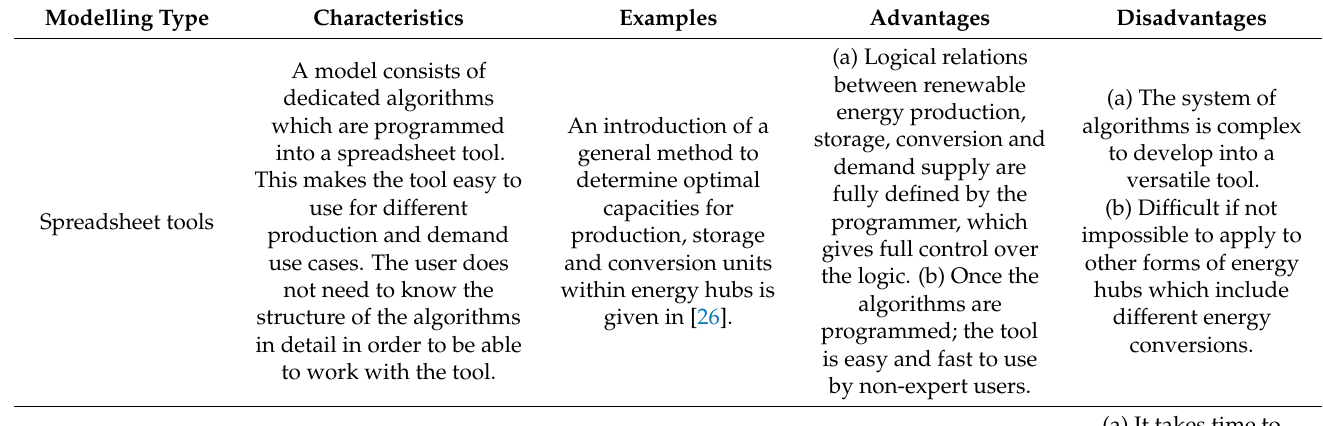
Table 1. Types of modelling tools for analysis of energy